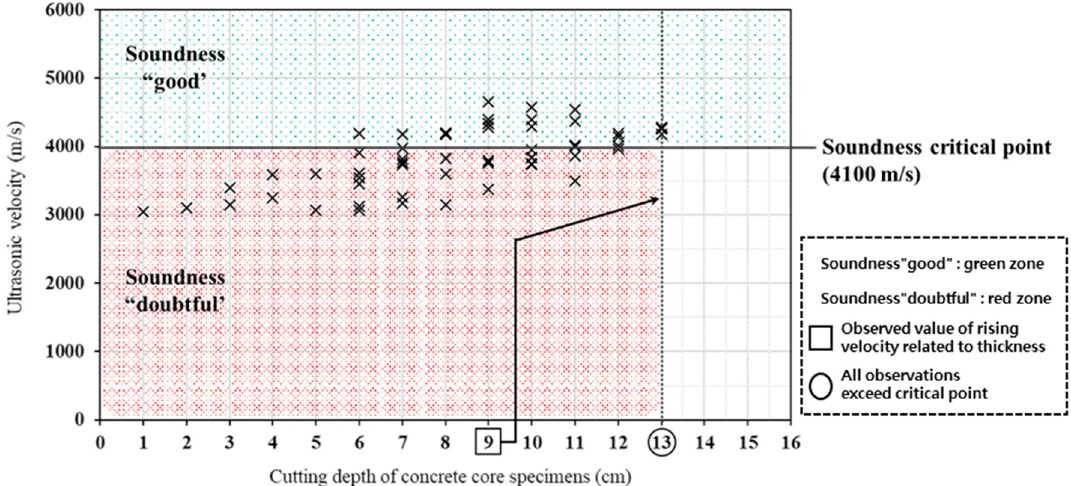
Figure 11. Ultrasonic velocity result according to the cutting thickness of the core specimens (Spalling severity with highest section).